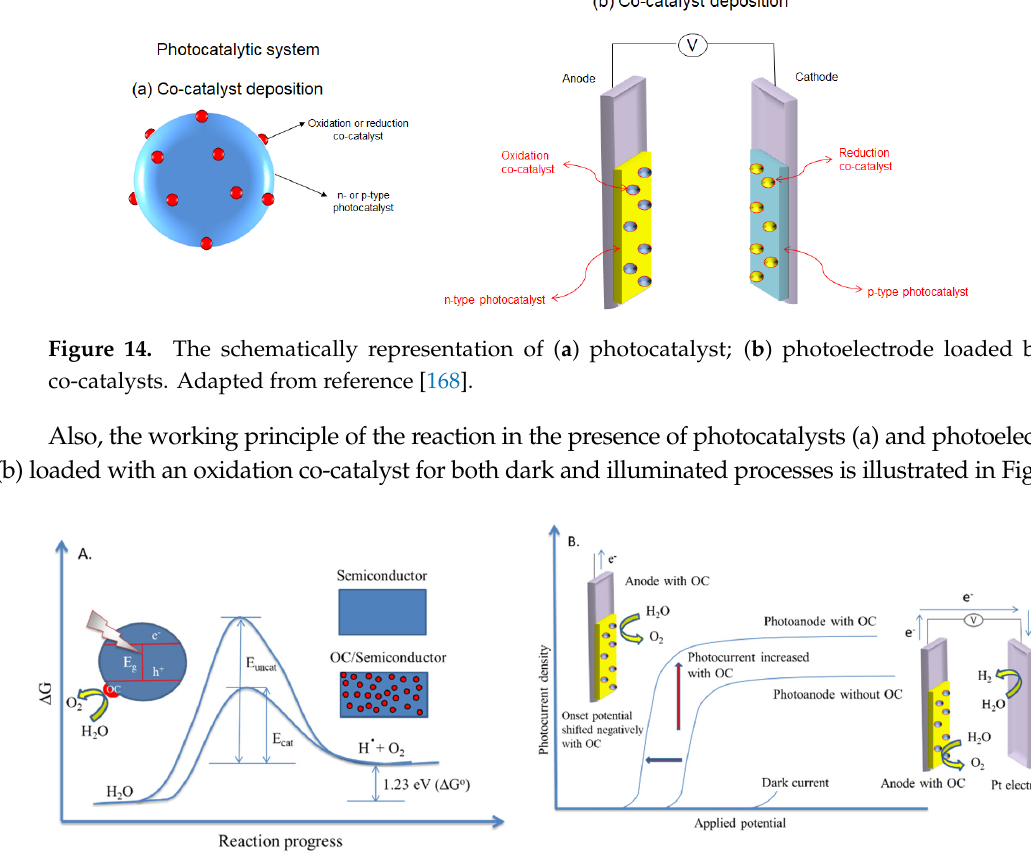
Figure 15. The working principle of the reaction in the presence of photocatalysts ( A ) and photocurrent density vs. the applied potential curves of photoelectrodes ( B ) loaded with an oxidation co-catalyst for both dark and illuminated processes, where OC — oxidation cocatalyst, E uncat — activation energy without OC and E cat — activation energy with OC. Adapted from references [168,228].